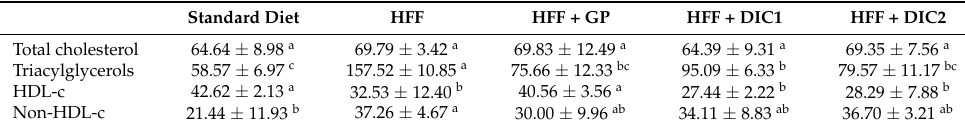
Table 4. Lipid profiles for sera of rats fed a HFF diet supplemented or not with grape pomace subjected or not to